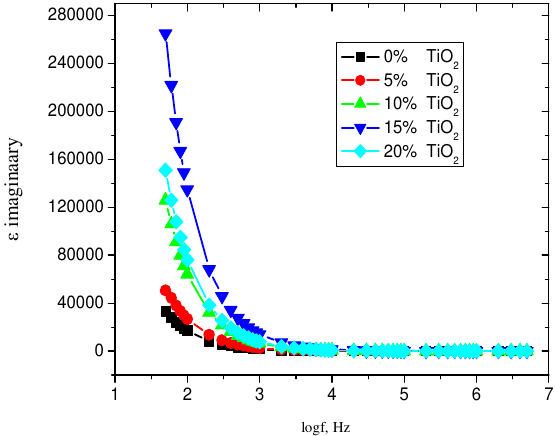
Figure 6. Variation of ε